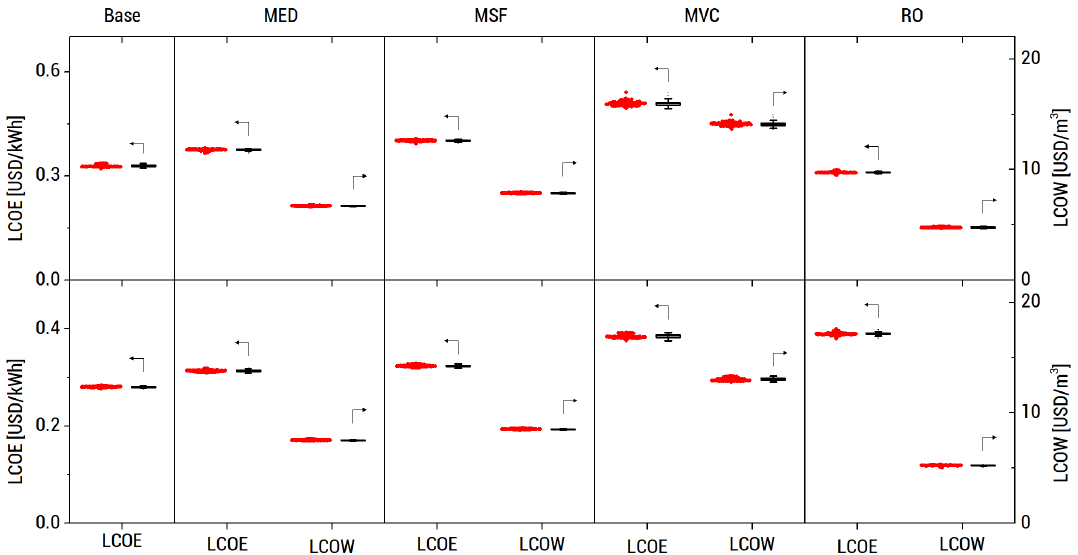
Figure 19. Distribution of optimum sizes of water storage and desalination unit on Camasusu Island ( top ) and Lubang Island ( bottom ) at + 25% overnight fuel price. There is minimal uncertainty in optimum sizes in all systems on both islands.